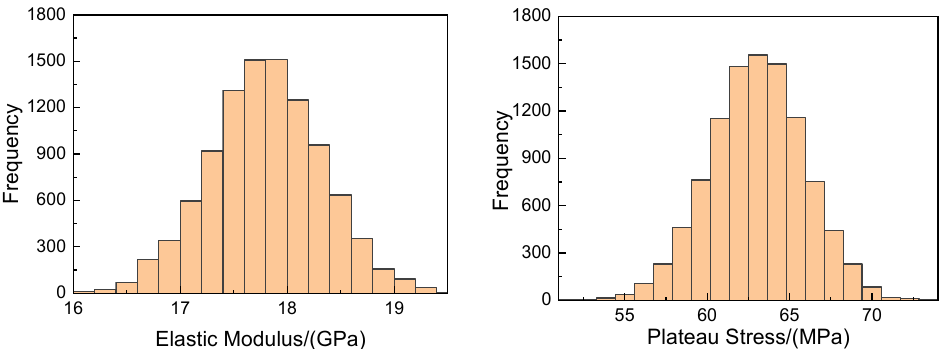
Figure 5. Elastic modulus and plateau stress distribution for 10,000 copies of porous aluminum al ‐ loy.